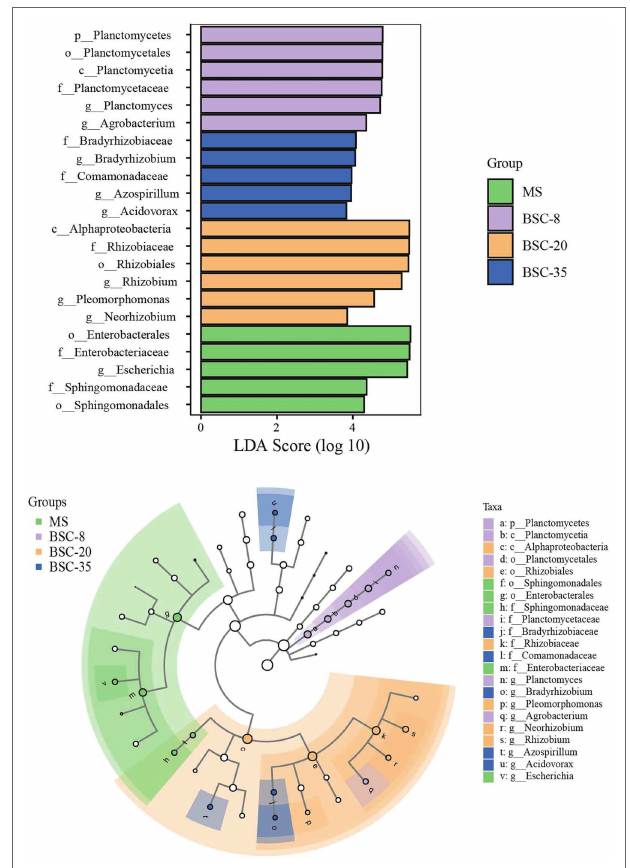
FIGURE 5 | The LEfSe method identifies the significantly different abundant taxa of the gcd community across different sites. Only the taxa with average abundances of >1% were considered significant. A significance level of 0.05 and an effect size threshold of 3 were used for all evaluated biomarkers. MS, moving sand dune; BSC-8, 8-year-old biological soil crust; BSC-20, 20-year- old biological soil crust; and BSC-35, 35-year-old biological soil